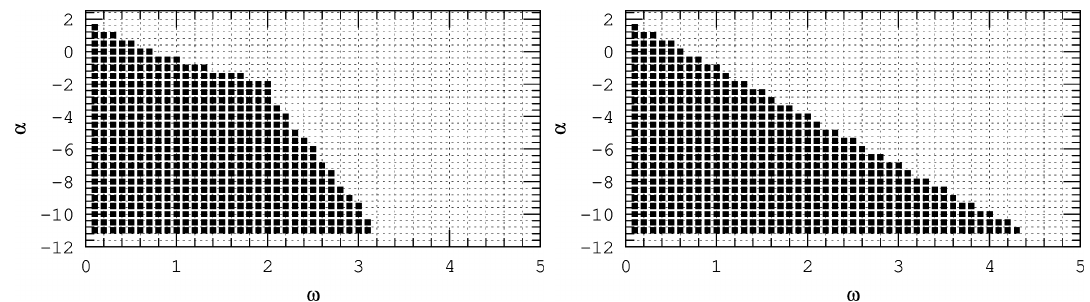
Fig. 1. Pairs .˛;!/ for which SOR-like converged. Fig. 2. Pairs .˛;!/ for which lSOR-like converged.